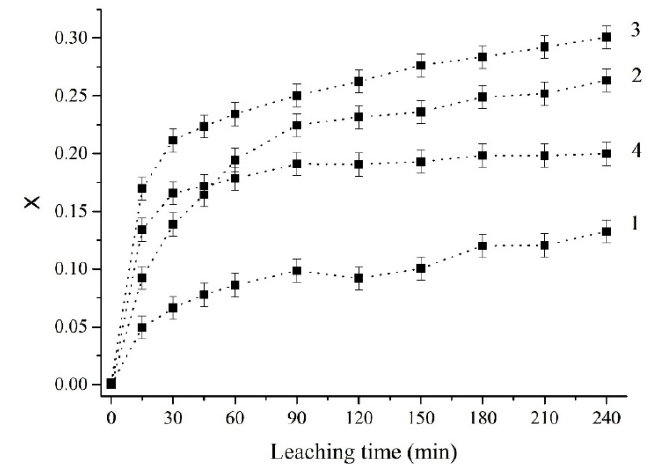
Figure 14. The kinetics of the leaching of ilmenite concentrate during processing in H 2 SO 4 (85 wt%) and mass ratio Ti:F = 1:1 at temperatures of 70 °C (1), 85 °C (2), 100 °C (3), 165 °C (4).